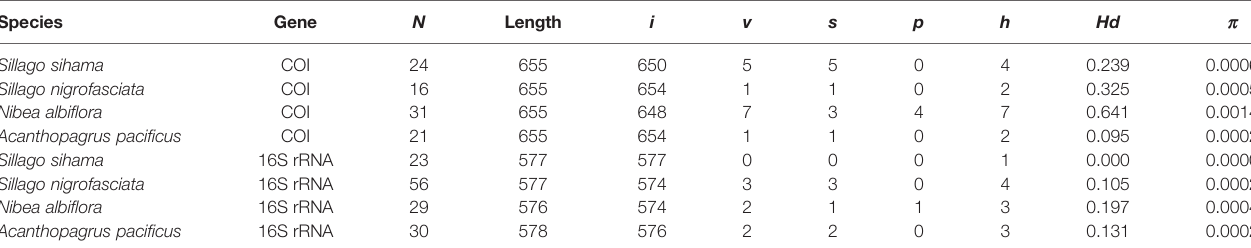
TABLE 2 | Summary statistics of sequence analysis for eggs and fi sh specimens from four species ( N , number of sequences; i , v , s , p , number of invariable sites, variable sites, singleton sites, and parsimony informative sites, respectively; h , number of haplotypes; Hd , haplotype diversity; p , nucleotide diversity). Species Gene N Length i v s p h Hd p Sillago